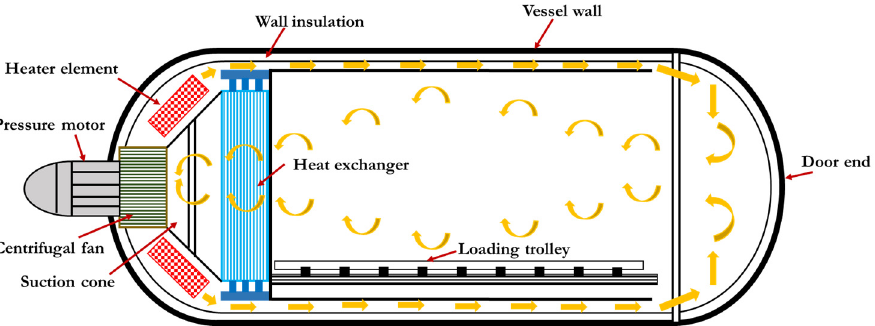
Figure 4. Schematic of air circulation and heating system in a typical autoclave (redrawn from [17]).